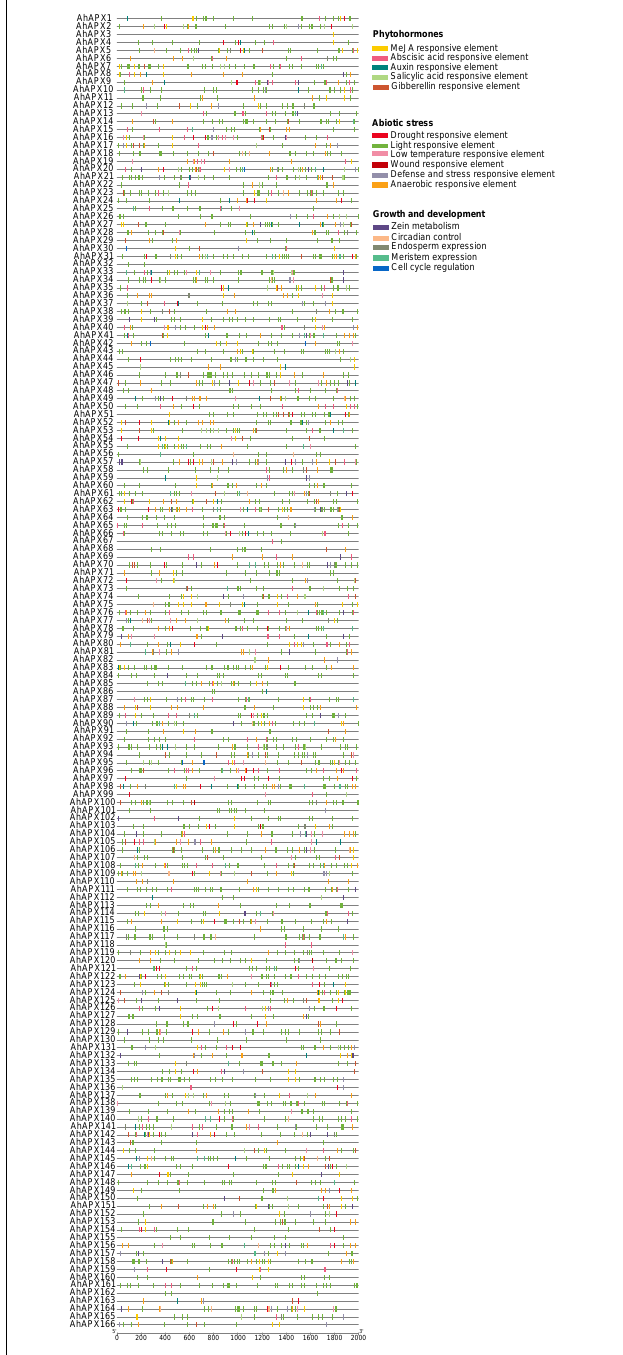
FIGURE 6 | Analysis of cis -regulatory elements in the AhAPX promoter regions. Diverse cis -elements with functional resemblance are represented by similar colors.